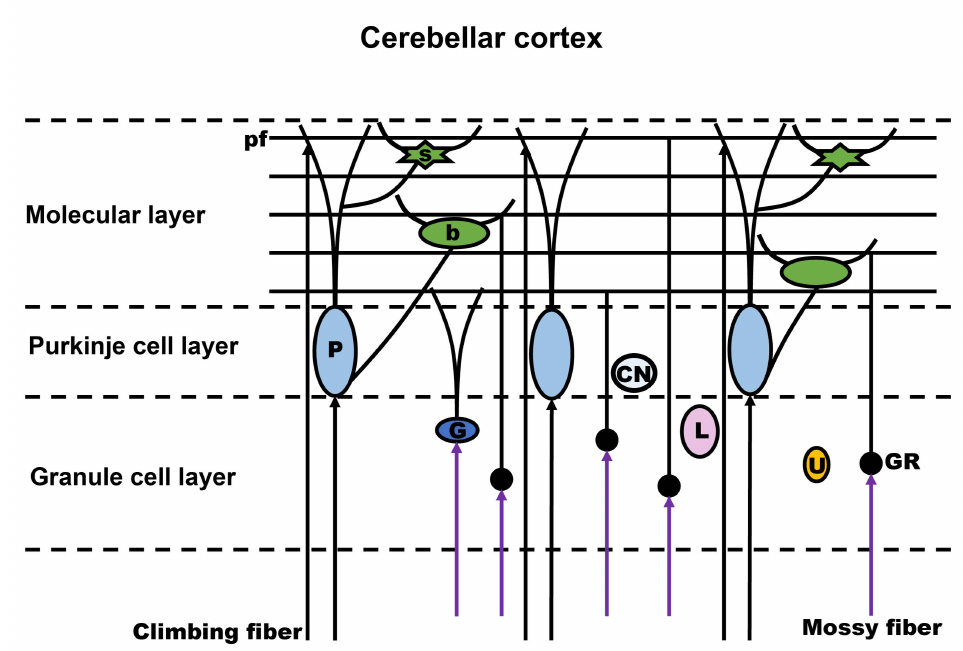
Figure 1. Main structure and circuitry of the cerebellum. pf, parallel fibers; P, Purkinje cell; G, Golgi cell; b, basket cell; s, stellate cell; GR, granule cell; CN, candelabrum cell; L, Lugaro cell; U, unipolar brush